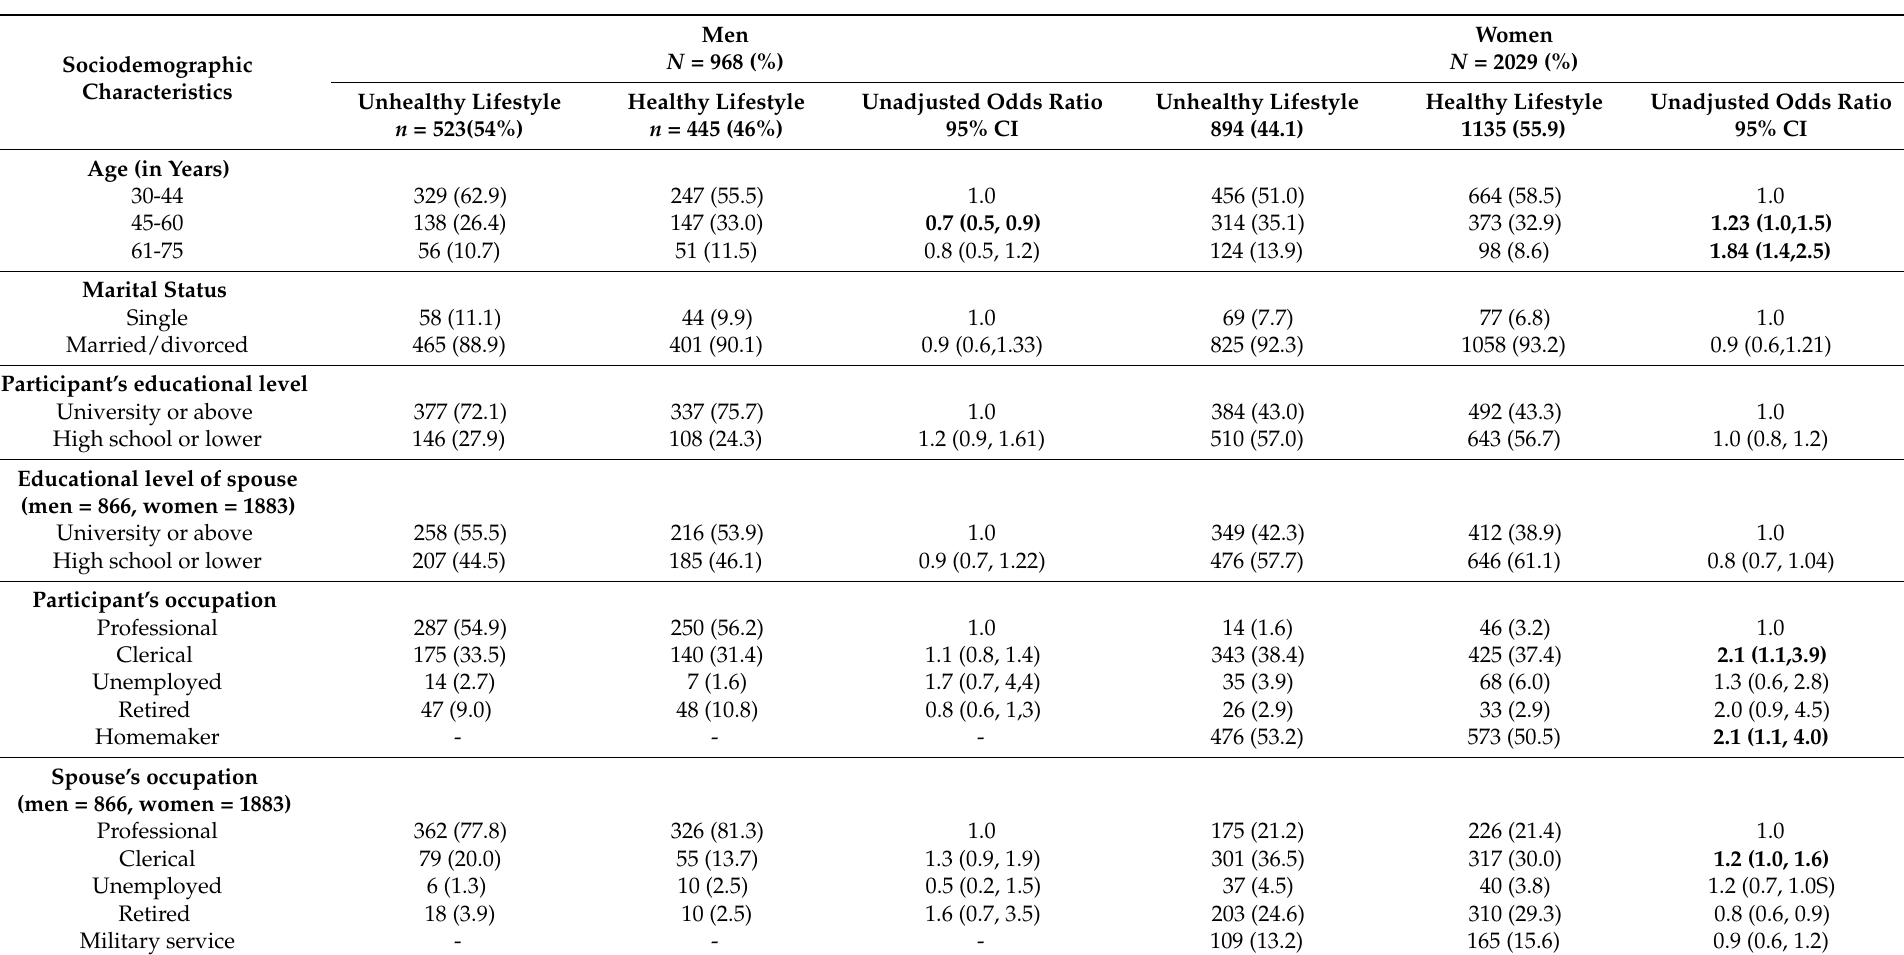
Table 2. Bivariate analysis showing unadjusted odds ratio and 95% confidence interval for sociodemographic factors associated with an unhealthy lifestyle in Saudi men and women in Riyadh, Saudi